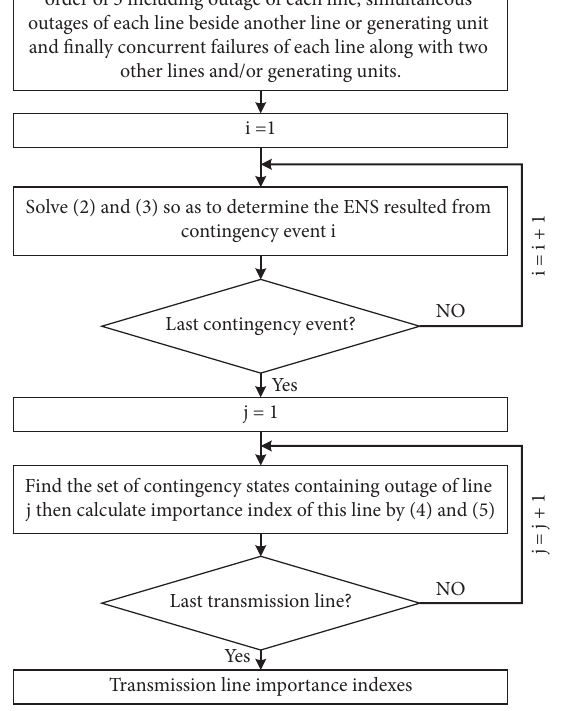
Figure 1: Te fowchart of determining importance